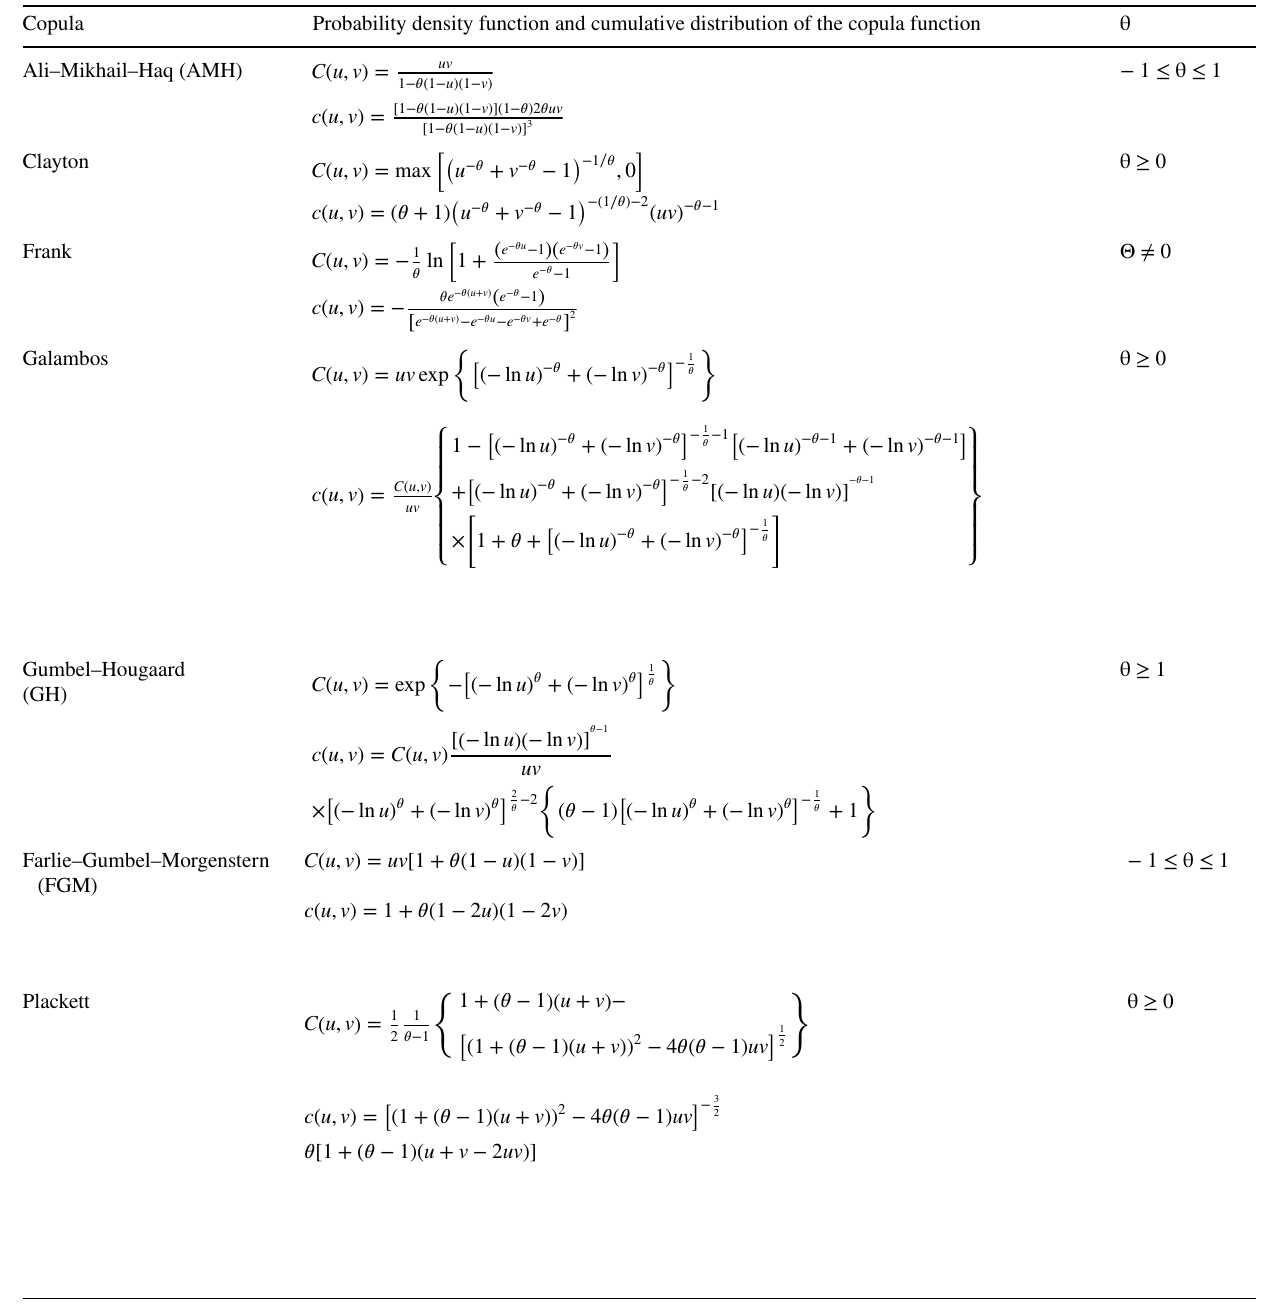
Table 1 Copula used (Nelson